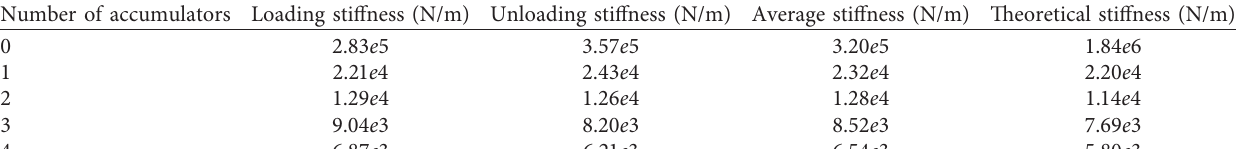
Table 2: The working stiffness of the MMSI.